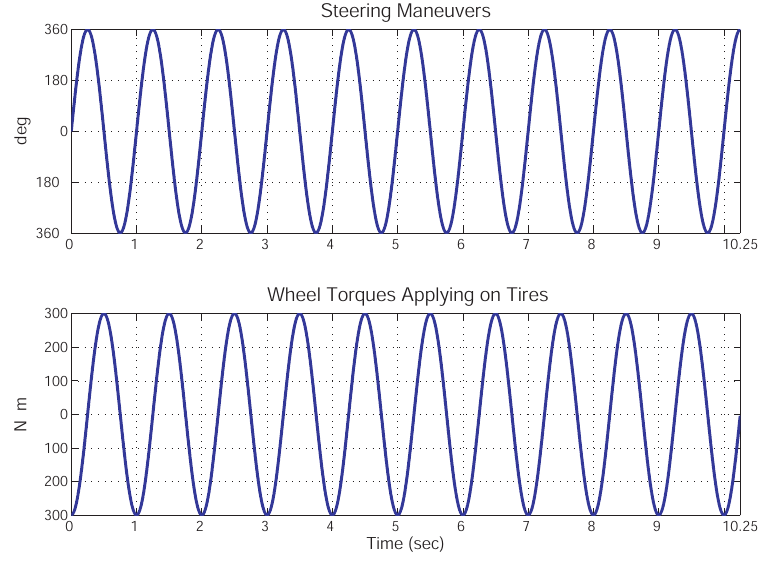
Figure 4. Comparisons of the vehicle dynamics from the simulated vehicle dynamics, the sensor outputs, and the sensor fusion system outputs. The vehicle dynamics are presented in the global frame. The error standard deviations are calculated from the 5th second to the 10th